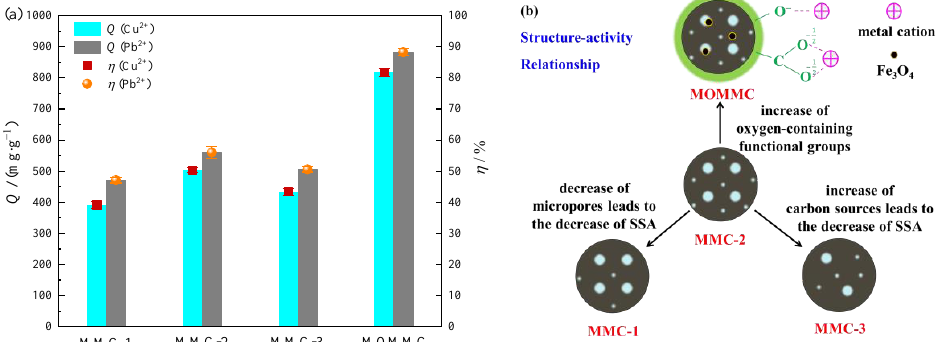
Figure 6. Adsorption capacity of different adsorbents ( a ) and the graphical analysis of the structure– activity relationship ( b ) ( C 0 = 1000 mg · L − 1 , pH = 5, T = 25 ◦ C, adsorbent concentration = 1 g · L − 1 , contact time = 120 min).